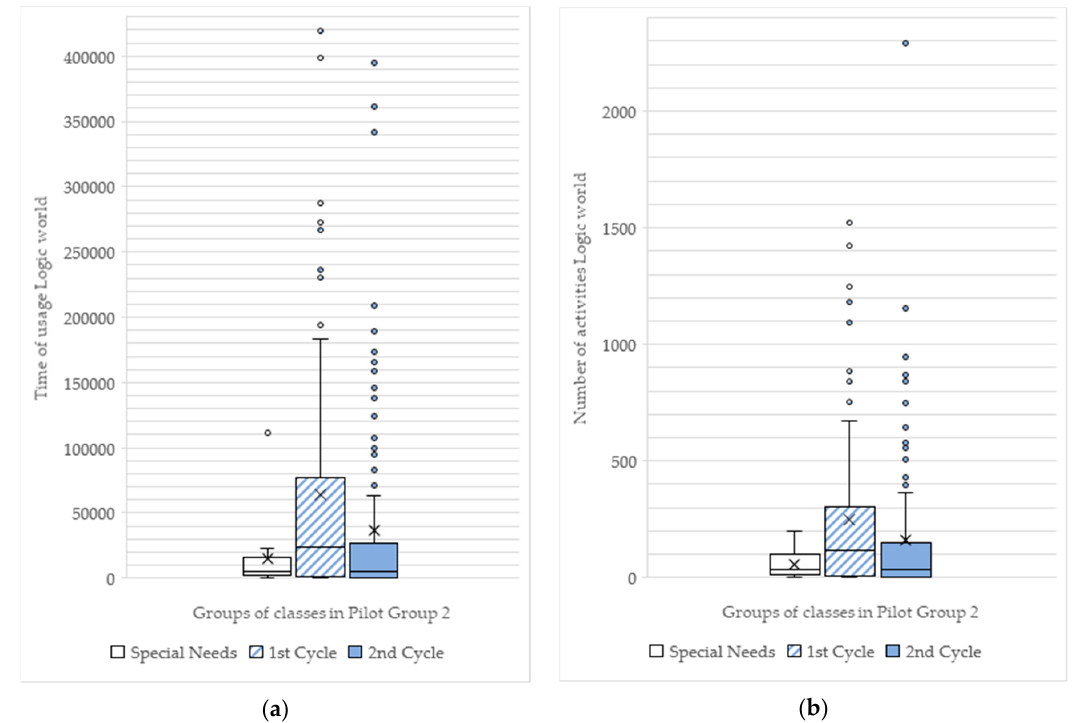
Figure 7. Descriptive statistic representation of significant results with one-way ANOVA. ( a ) Figure showing major results for ‘time of usage’ among class groups in the world Logic. ( b ) Figure showing major results for ‘time of usage’ among class groups in the world Science.